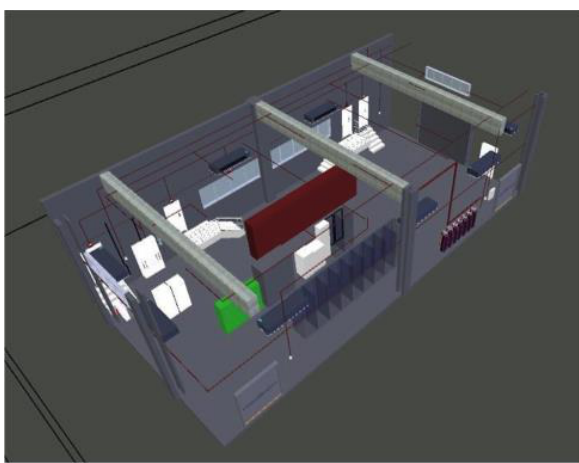
Figure 11: Complete 3D BIM Model of 132/22KV Control and Relay room